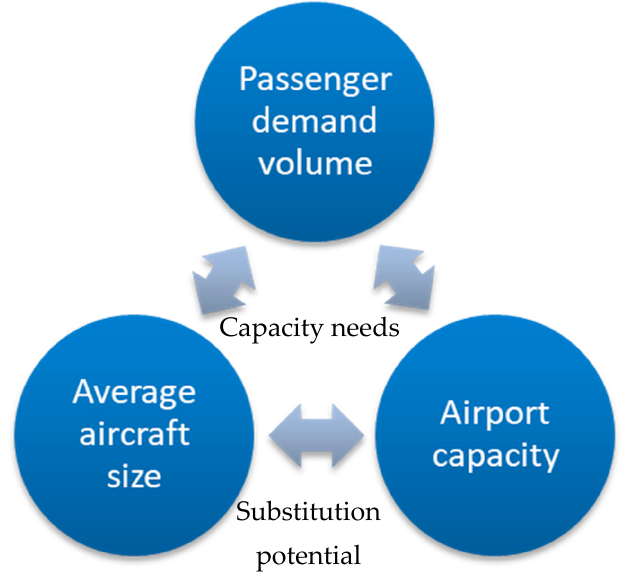
Figure 2. Relationship between passenger demand, airport capacity and aircraft size. Reprinted from Ref. [7].